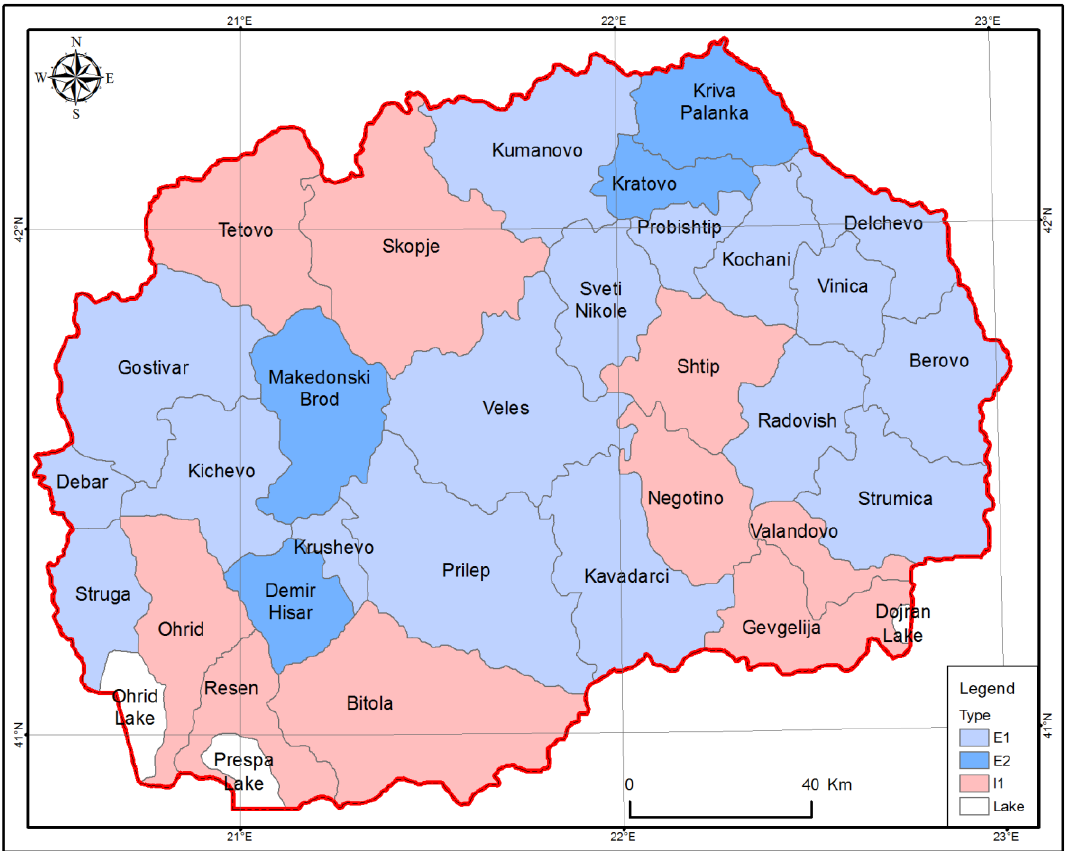
Fig. 2. Migration types by municipalities in the period